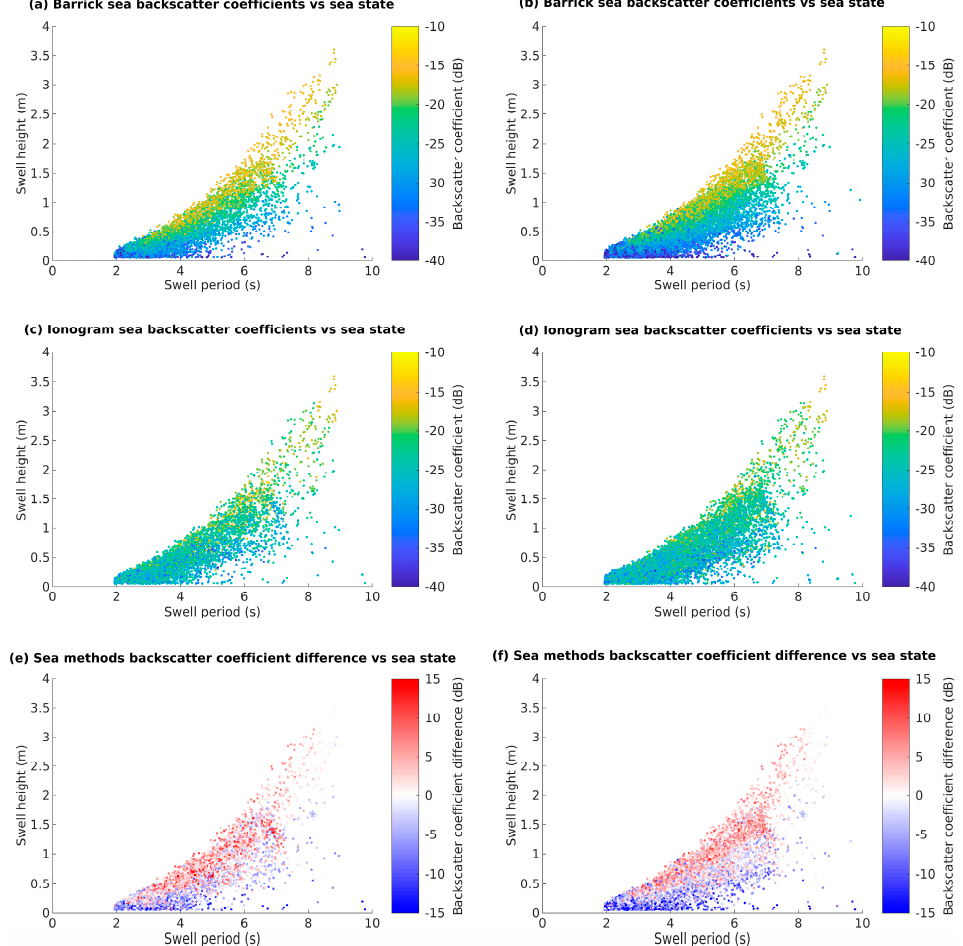
Figure 10. Sea surface backscatter coefficients vs. sea state using data from September 2015 and March 2016 for Longreach ( left ) and Alice Springs ( right ).